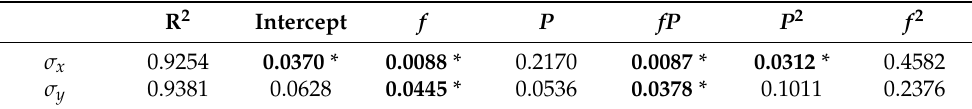
Table 6. R 2 value and p -value for individual structural elements of regression Table 7. Results of surface roughness of the EN AW-2024-T3 aluminum alloy burnished using a diamond tool.